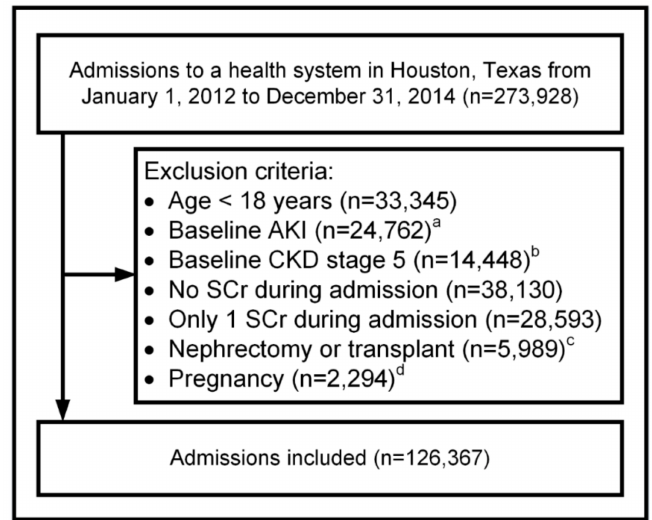
Figure 1. Patient inclusion flowchart. AKI, acute kidney injury; CKD, chronic kidney disease; SCr, serum creatinine. a AKI was defined as one of the following International Classification of Diseases Ninth Revision Clinical Modification (ICD-9-CM) codes that were present upon admission: 584.5, 584.6, 584.7, 584.8, or 584.9; b CKD stage 5 present upon admission was identified using ICD-9-CM codes (585.5 or 585.6) or as an estimated glomerular filtration rate of <15 mL/min/1.73 m 2 using the first SCr available during the hospital stay; c Detected using principal procedures and the Agency for Healthcare Research and Quality (AHRQ) Clinical Classification Software (CCS) Procedure Class of 104 for nephrectomy, 105 for kidney transplant, and 176 for other types of solid organ transplant; d Detected using ICD-9-CM codes and the AHRQ clinical classification system categories 180 to 196. Table 1. Demographic and clinical characteristics of admissions to a hospital system evaluated for the incidence of acute kidney injury. Study Sample Characteristic ( n =